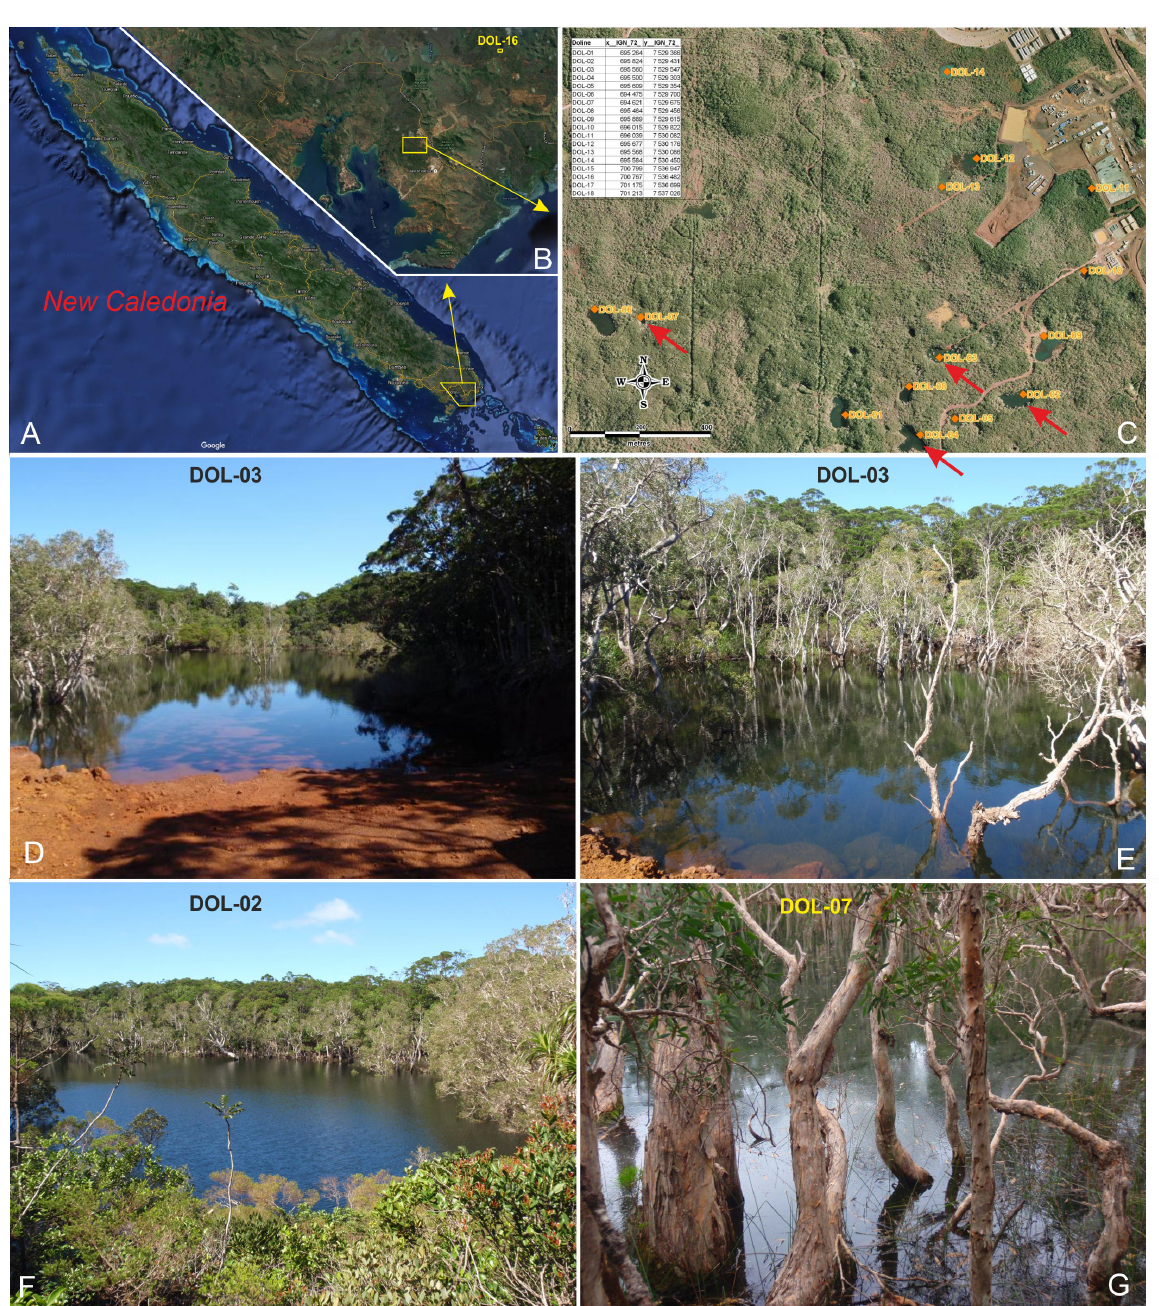
Fig. 1. Aerial photographs of the distribution area of Lynceus insularis sp. nov. in New Caledonia and photographs of the type locality. A . Overview of New Caledonia. B . Close-up of southern part of New Caledonia with position of localities where L. insularis sp. nov. has been found. C . Overview of mining area with four out of the five sinkholes where L. insularis sp. nov. has been found. The type locality is DOL-03. The fifth locality (DOL-16) is approximately 9 km NE of DOL-03, outside of the area shown. D–E . Type locality (DOL-03) of L. insularis sp. nov. F–G . Additional localities of D. insularis sp. nov., DOL-02 and DOL-07, respectively. A–C modified from Google